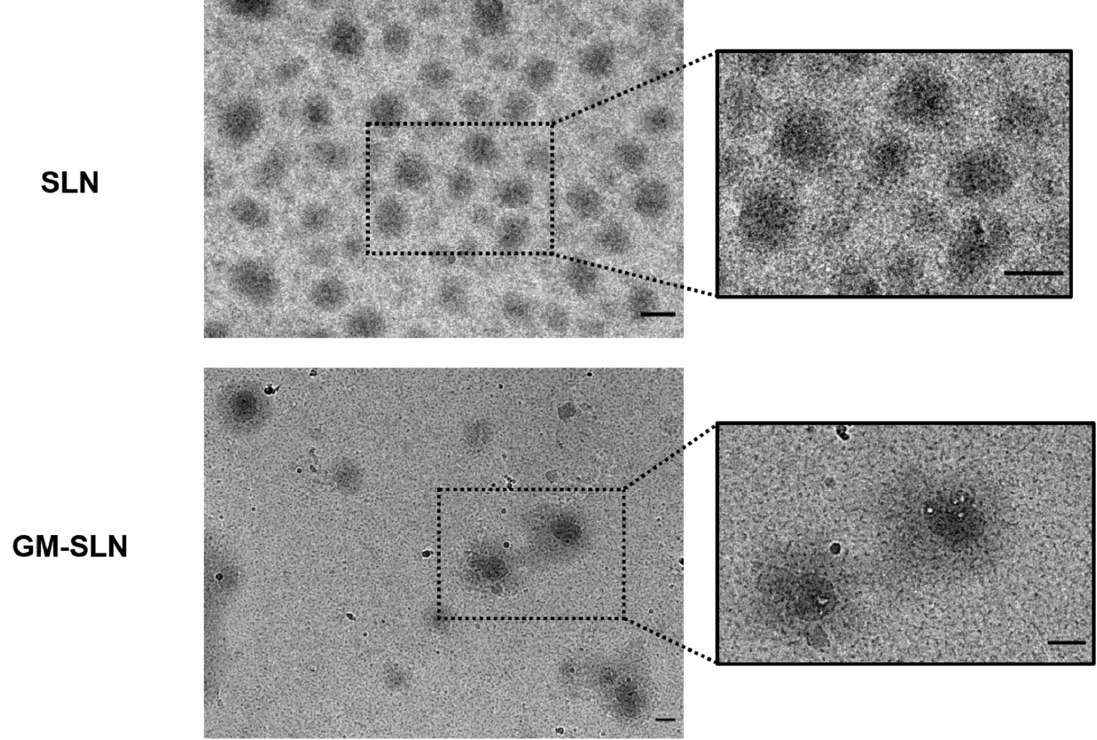
Figure 4. Cryo-Transmission Electron Microscopy (Cryo-TEM) images of the SLNs and the GM-SLN vector. Scale bars = 100 nm. GM-SLN: galactomannan SLN-based vector. SLN: solid lipid nanoparticle.